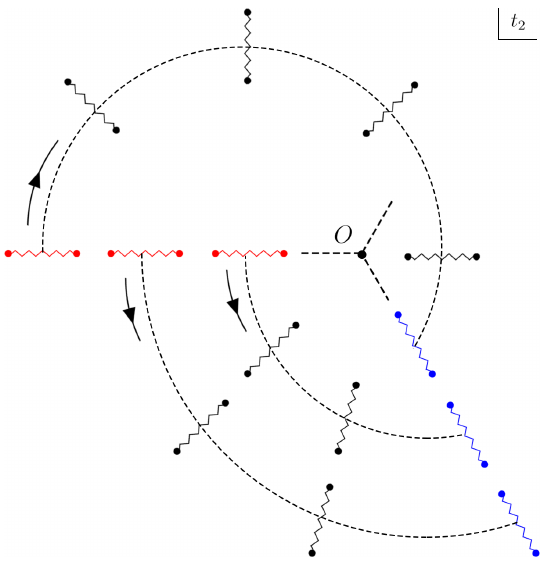
Figure 16 . The transformations of branch cuts on the t 2 -plane following the path from O to O 0 on the U -plane for SU(3) 0